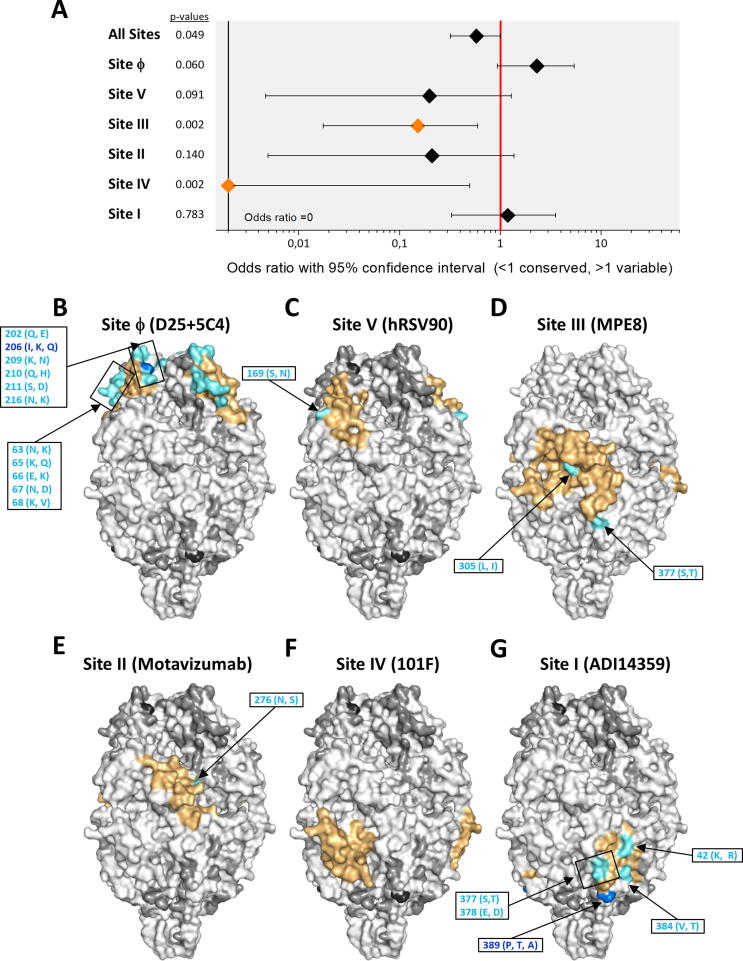
Location of amino acid differences between A2 and bRSV strains on the structure of prefusion hRSV F. Structures and changes are shown as in Fig. 3. The changes are listed in Supplementary Table S3.